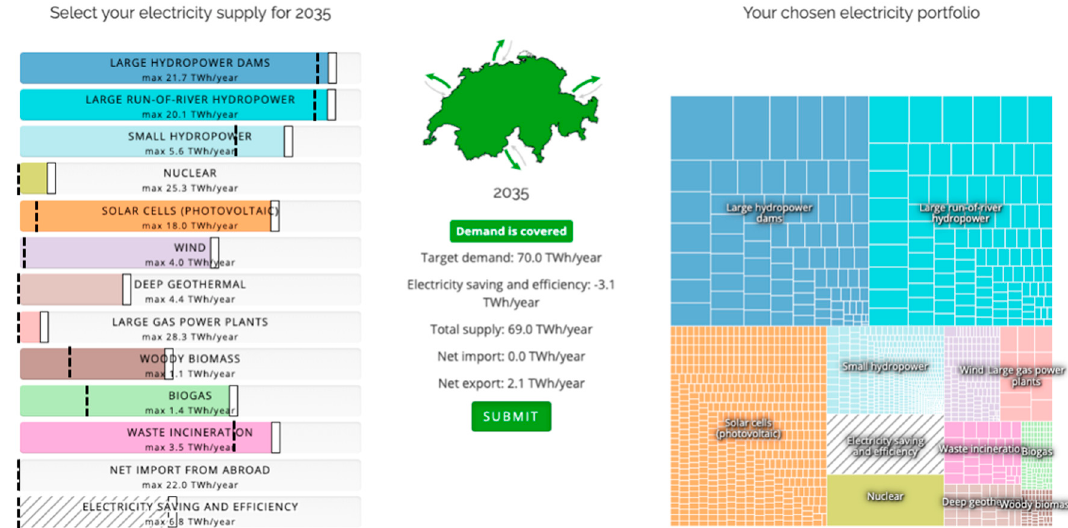
Figure 4. Average final preferred electricity mix for Switzerland for 2035 in Riskmeter [66] (Section 2.1). The white markers on the left panel show the means (N = 44) and Table 1 provides the standard deviations. The black dashed lines show the lower bound for each technology, corresponding to already installed generation in Switzerland that will last until 2035.